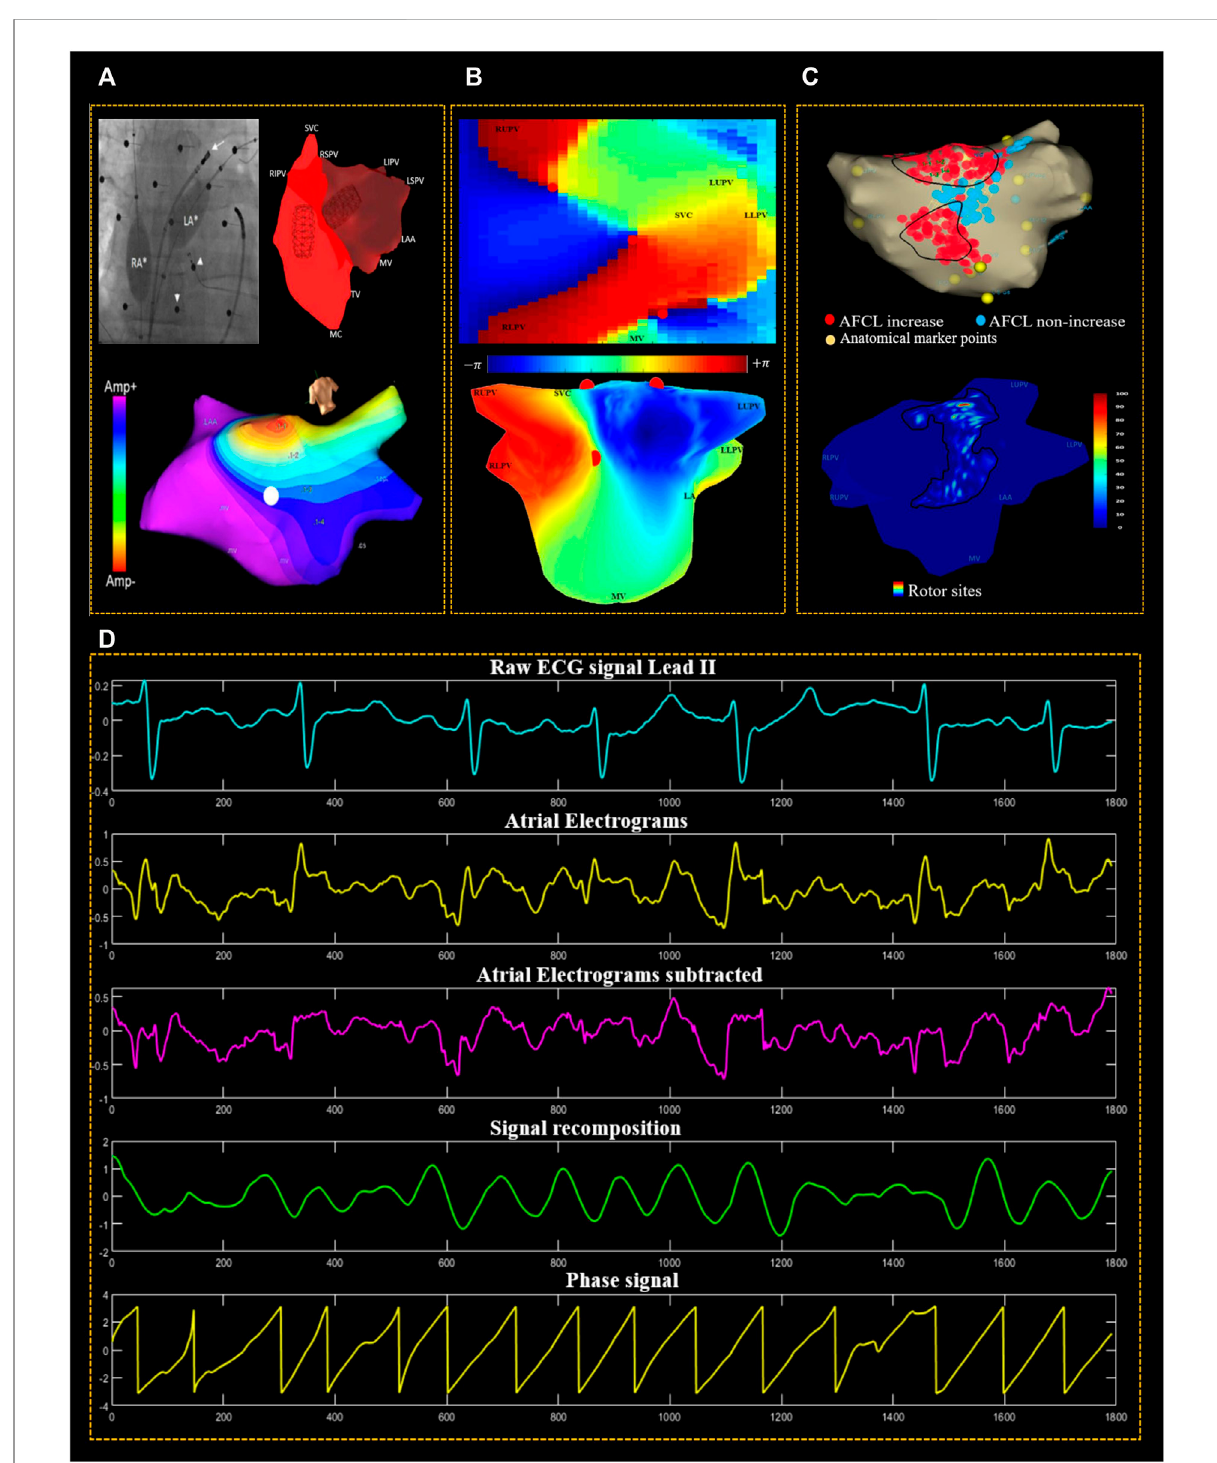
FIGURE 1 The methodological procedure used for data acquisition and signal processing. (A) Fluoroscopic image of the non-contact balloon catheters deployed in both the left atrium (LA) and right atrium (RA) (white asterisks). The small white arrows heads point at the active electrodes of the body surface mapping (BSM), and the white arrow points at the ablation catheter. The screenshot of the EnSite velocity mapping system illustrates the LA geometryisopotential/voltage map. (B) Reconstructed2D&3Dofleftatrialgeometrywithacolour-codedphasemap;thecolour barindicates that the phase varies from − π to + π and the colour coding represents this 2 π phase range from blue to red. PSs are represented by red circles. (C) LA